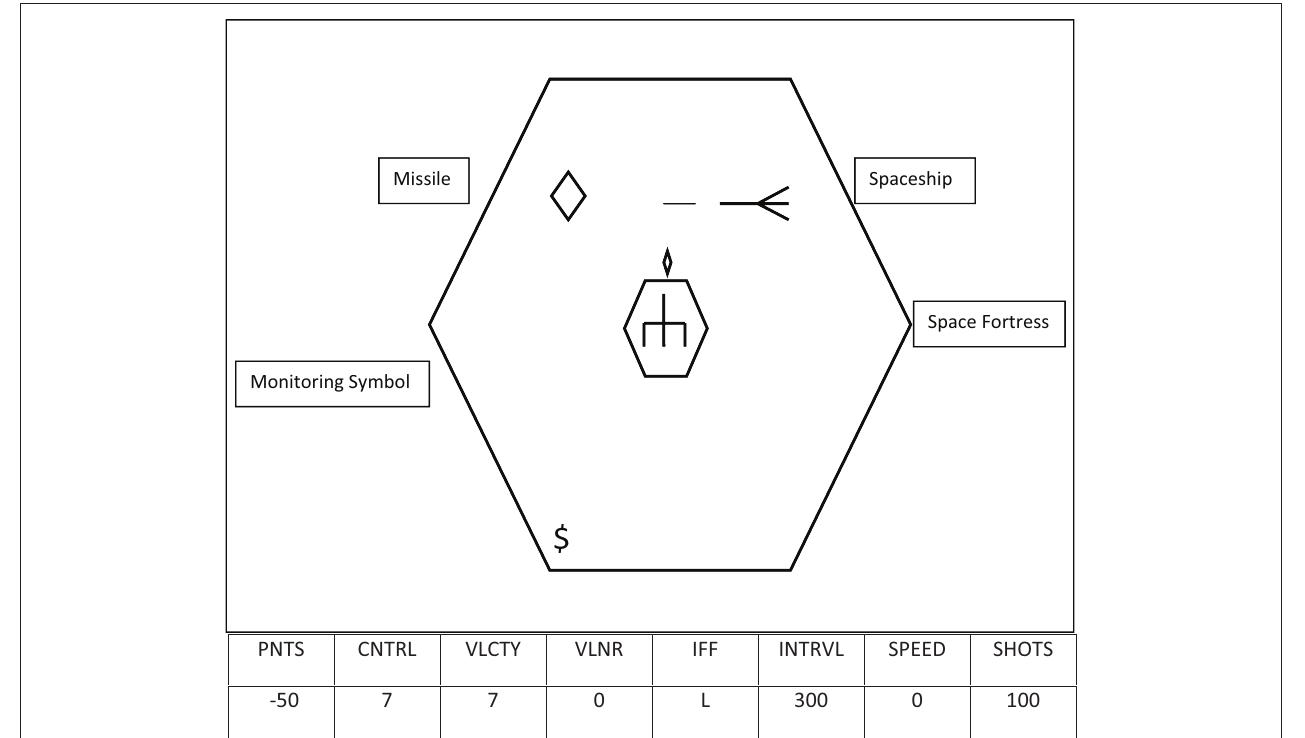
FiGurE 1 | A Schematic of the revised Space Fortress game